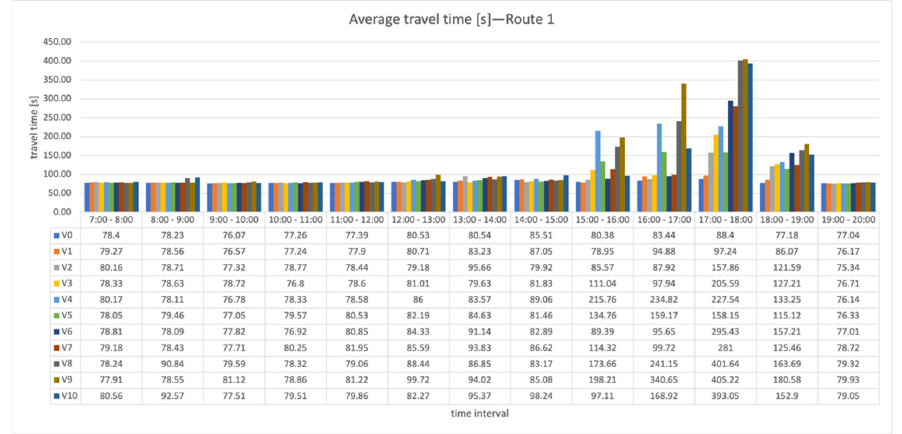
Figure 7. Average travel time; Section 1—all variants.